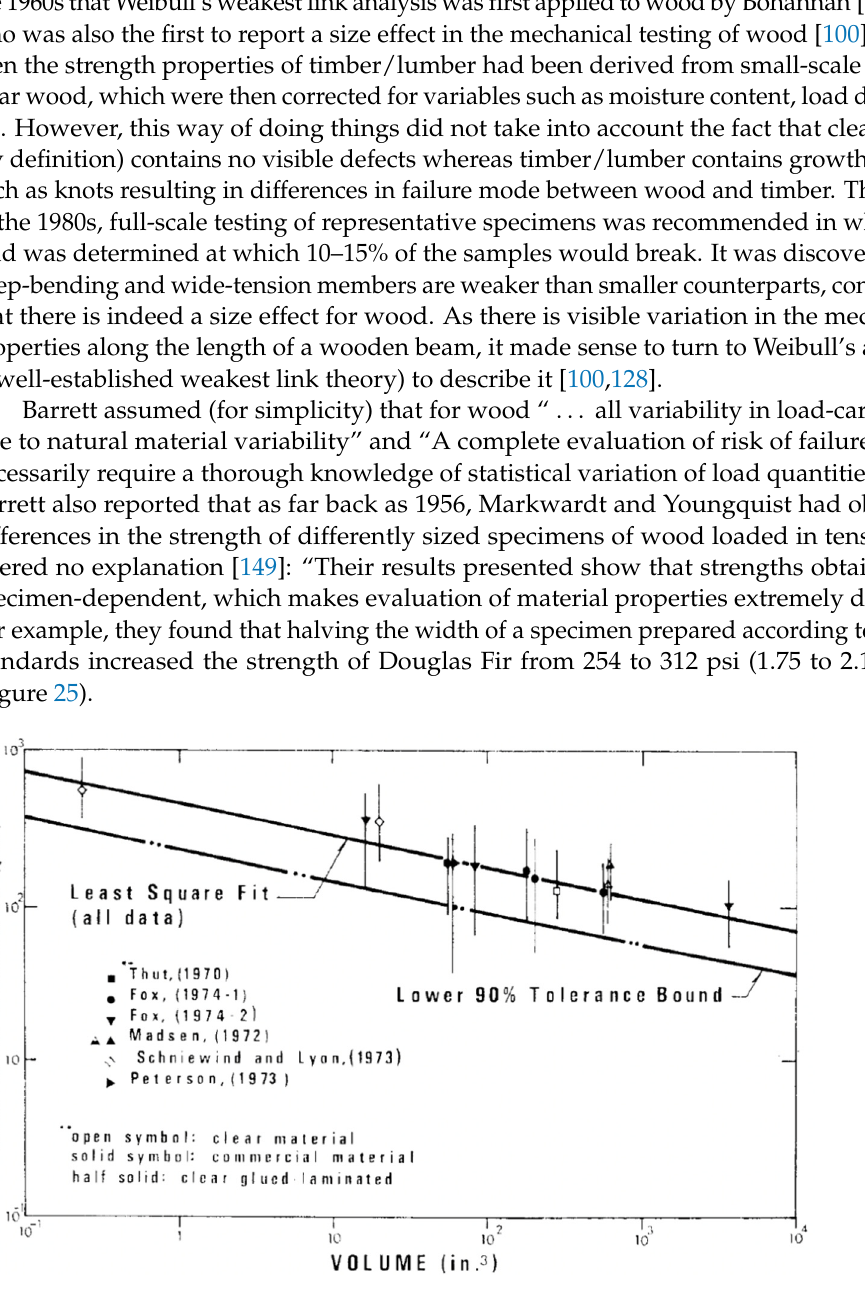
Figure 25. Relationship between strength and volume for uniformly loaded Douglas Fir